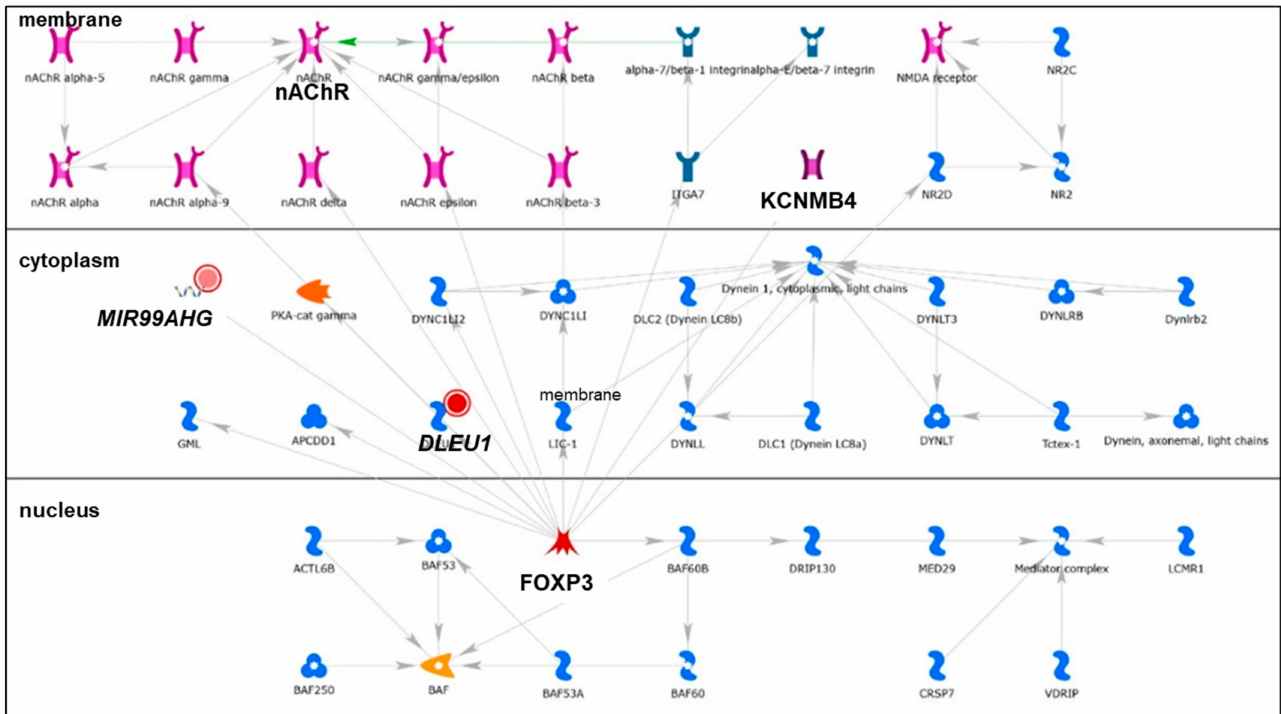
Figure 4. Network 4: DLEU1, MIR99AHG, FOXP3, KCNMB4 , and nAChR delta, identified in lncRNAs downregulated by miR-29b-1-3p and miR-29a-3p in MCF-7 and/or LCC9 cells by MetaCore analysis. Green lines with arrows = stimulation; red lines with arrows = inhibition. nAChR = nicotinic acetylcholine receptor delta ( CHRND ). nAChRs are present in breast tumors (reviewed in